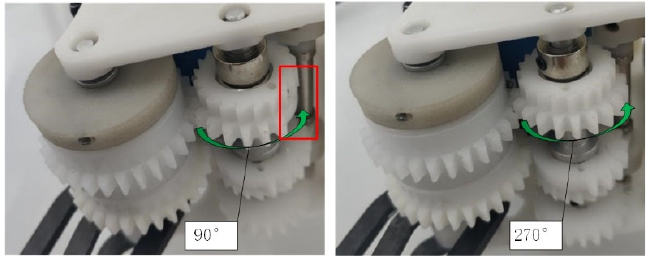
Figure 15. Schematic diagram of different torsion degrees of torsion spring (left) 90° (right) 270°.